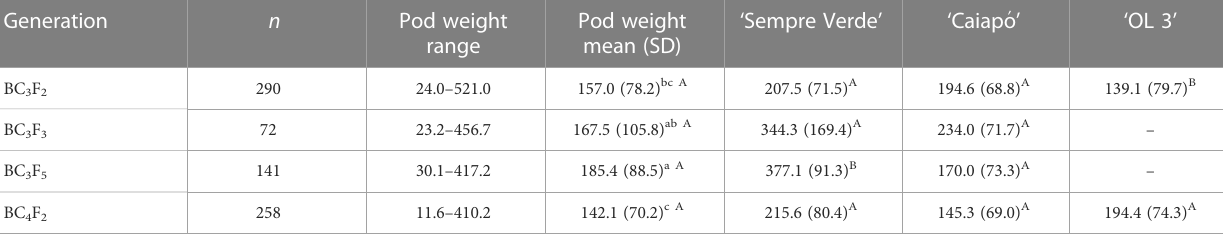
TABLE 2 Number of plants evaluated ( n ), pod weight range per plant, and mean (g) of generations BC 3 F 2 , BC 3 F 3 , BC 3 F 5 , and BC 4 F 2 of selected plants with introgressions from Arachis stenosperma and A. magna